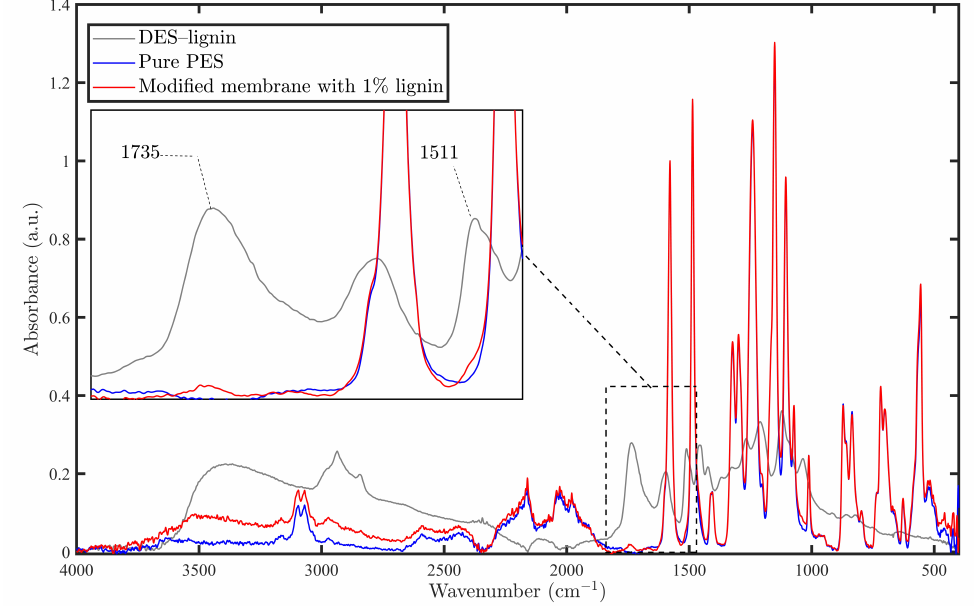
Figure 2. ATR-FTIR spectra of virgin and modified membrane with 1% DES-lignin in the region of 4000–400 cm − 1 . Non-overlapping peaks related to DES-lignin can be detected at 1511 cm − 1 , 1735 cm − 1 and broad band between 3200 and 3600 cm − 1